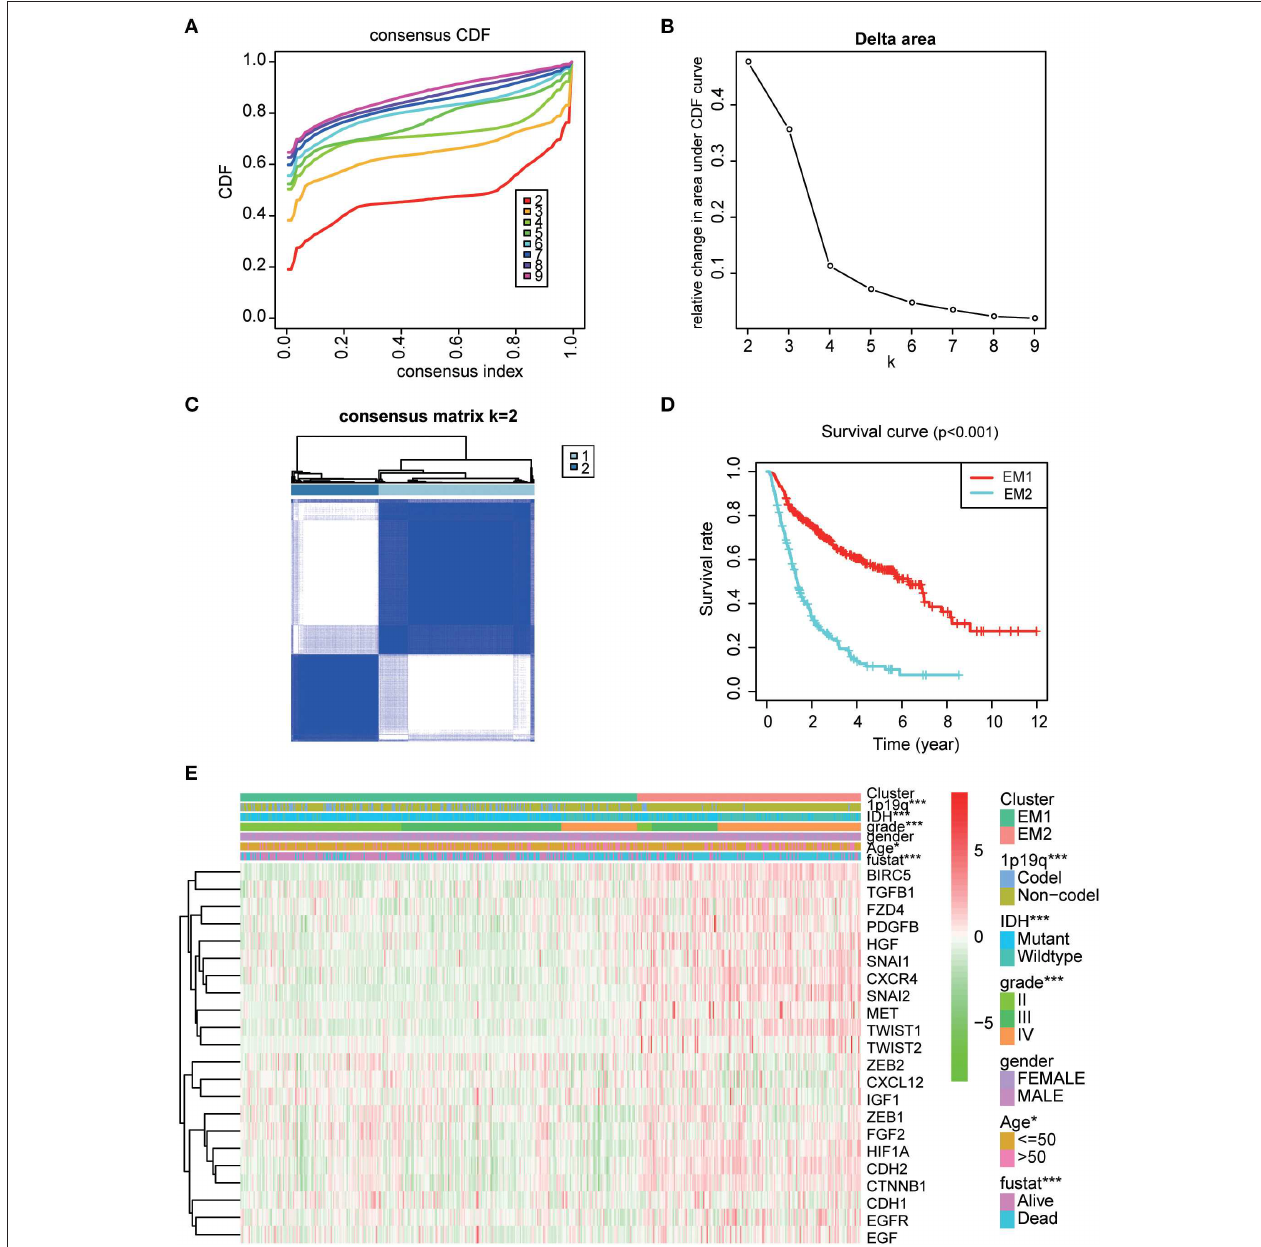
FIGURE 4 | The distinction of clinicopathological features and OS of gliomas in the EM1/2 subgroups. (A) Consensus clustering cumulative distribution function (CDF) for k = 2–9. (B) Relative change in area under CDF curve for k = 2–9. (C) Correlation between the EM1 and EM2 subgroups. (D) Kaplan–Meier overall survival (OS) curves for 508 CGGA samples. (E) Heatmap and clinicopathologic features of the two clusters (EM1/2) defined by the EMT related genes consensus